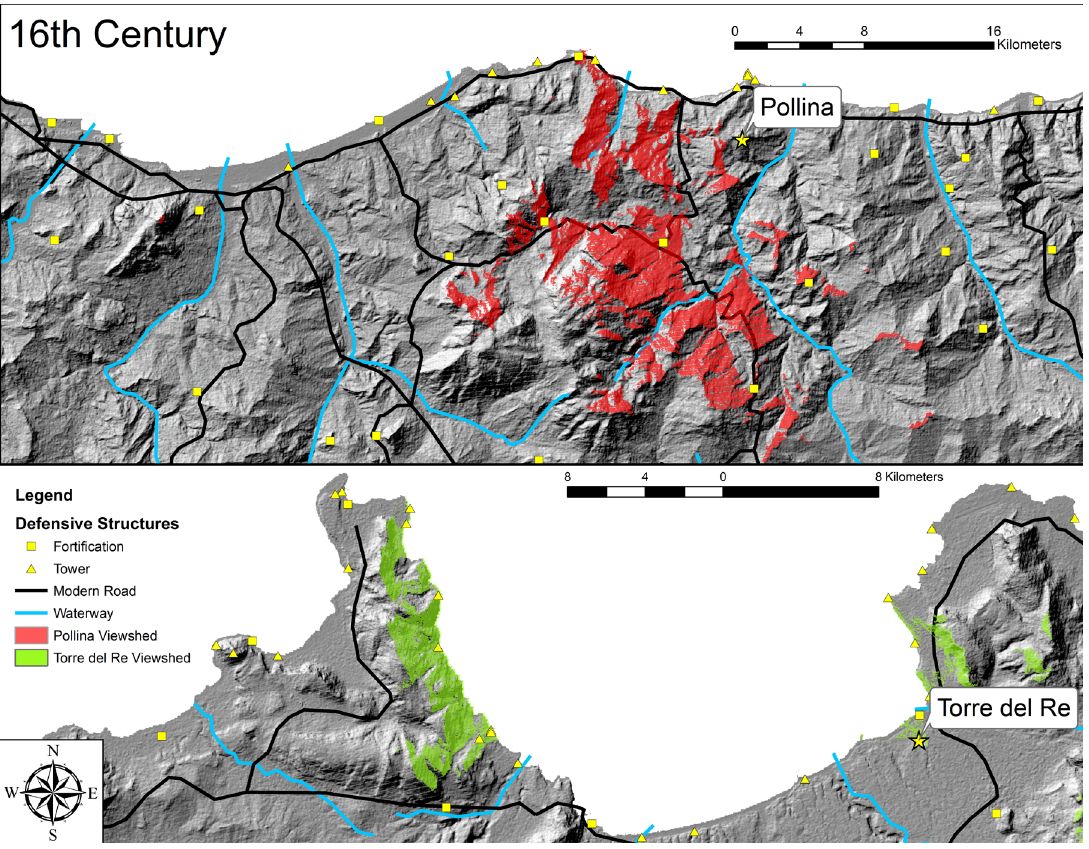
Figure 11. Figure showing the viewshed of the Castle of Pollina (top) and the Torre del Re (bottom) in the 16th century. View- sheds derived from an ASTER GDEM (a product of NASA and METI). Modern roads and waterways from Hijmans et al. (2012). Starting with the castle at Pollina, it is easy to see that the structure was designed primarily for keeping both the mountain pass and waterway directly to the south and west of it under surveillance, with only a minimal amount of coastal territory visible within its viewshed. As is to be expected, other defensive structures seen from Pollina largely consist of other castles, with only one tower seen within its viewshed. Nonetheless, it